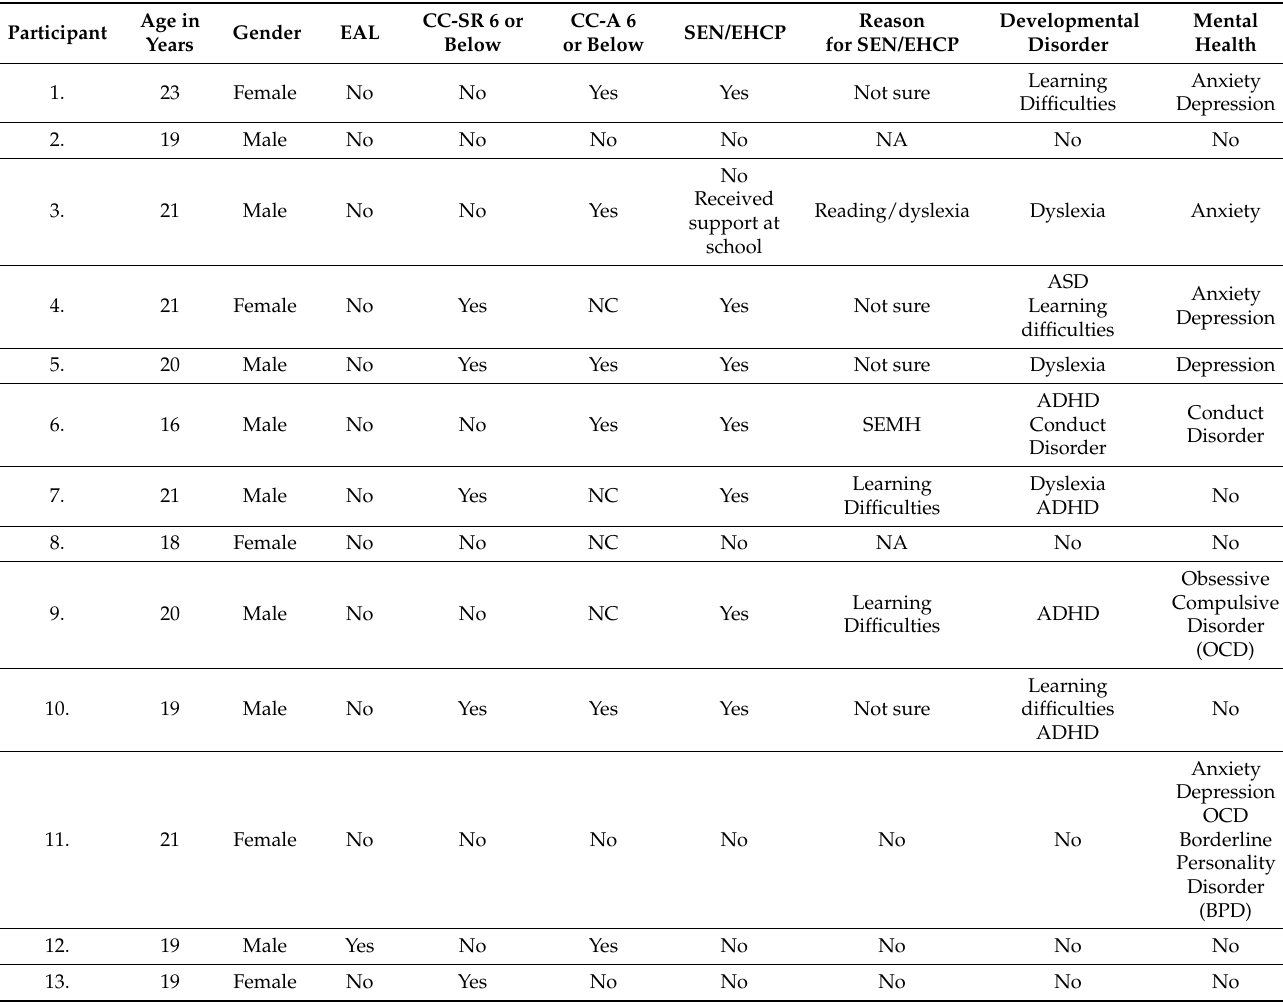
Table A2. Profile of the participants (n = 26) with CELF-5 UK scores in the very low/severe range ( − 2 SD and